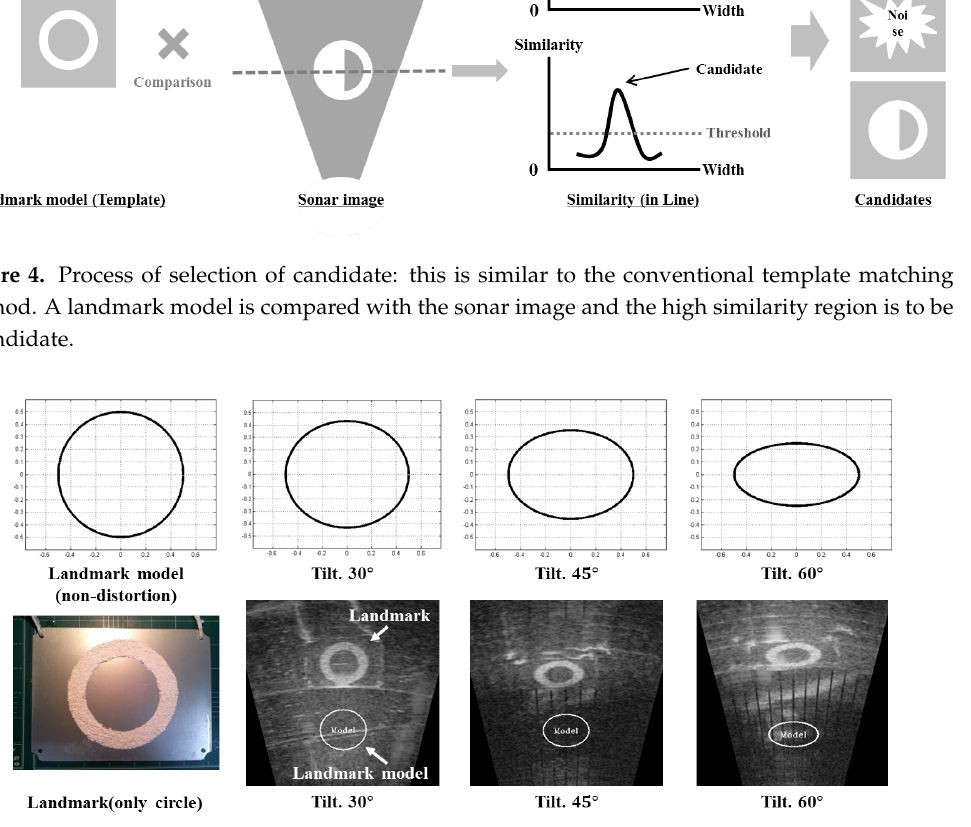
Figure 5. Landmark models according to tilt (downward) of sonar.